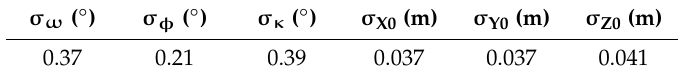
Table 3. Estimated standard deviation of the exterior orientation parameters: Omega ( σ ω ), phi ( σ φ ), and kappa ( σ κ ) in degrees and camera perspective center in